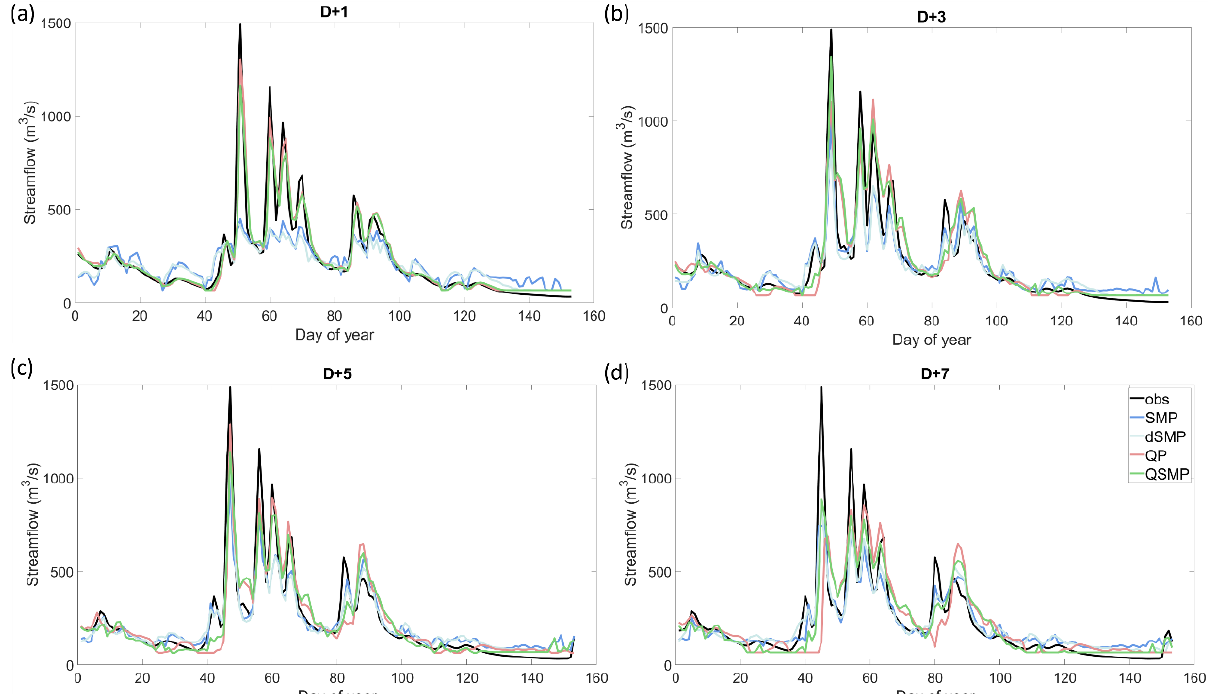
Figure 9. Hydrographs for the Androscoggin watershed for summer 2009 (validation period) ( a ) 1, ( b ) 3, ( c ) 5 and ( d ) 7 days in advance.